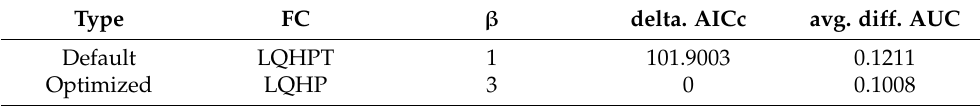
Table 2. Evaluation metrics of MaxEnt model generated by